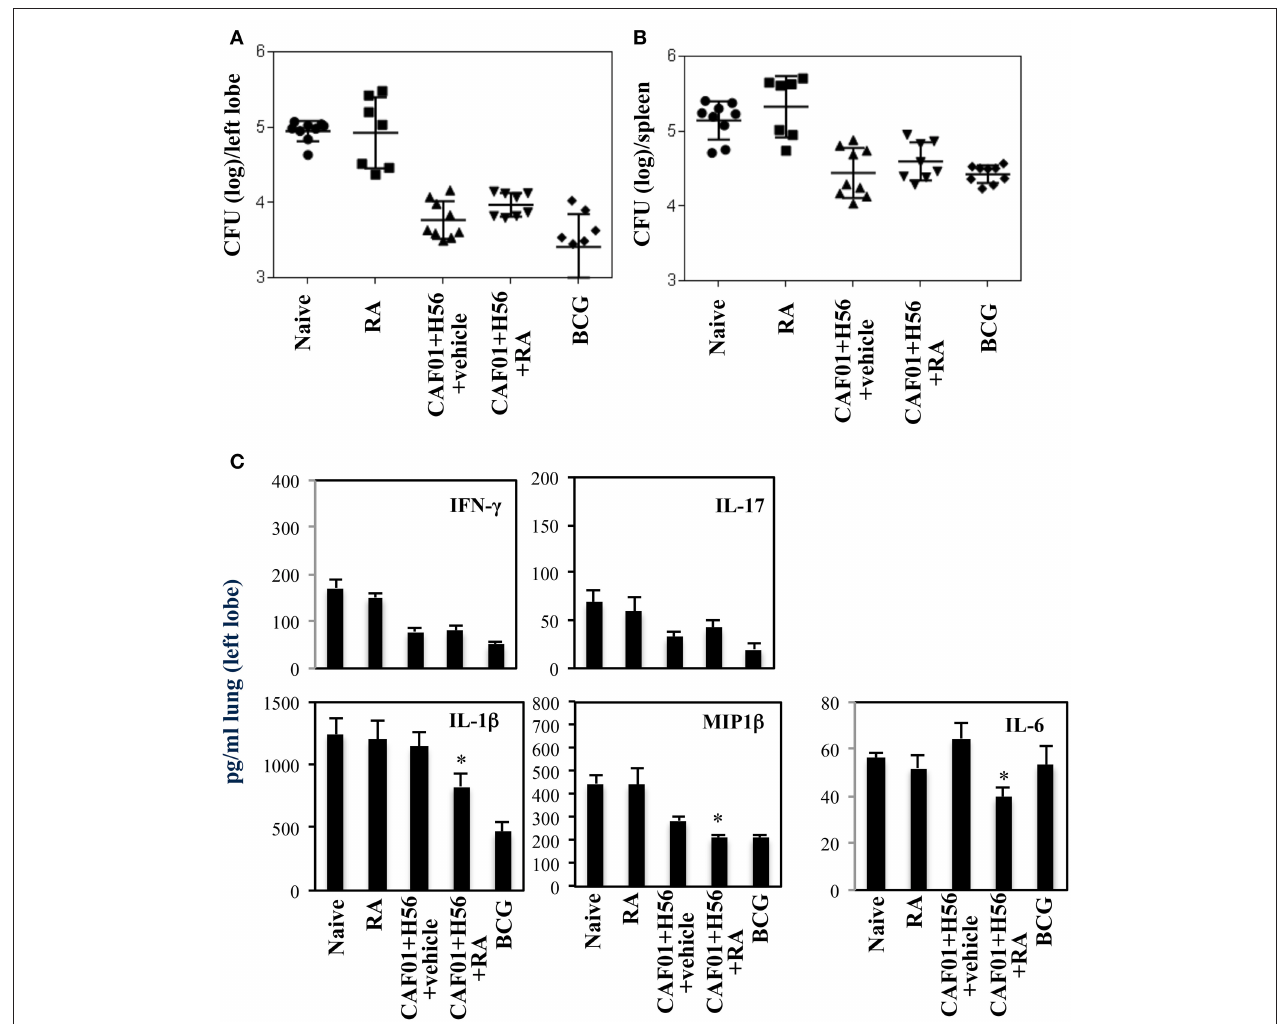
FIGURE 5 | Colony forming unit (CFU) in the lung (A) and in the spleen (B) of CB6F1 mice 6 weeks after Mtb infection. Mice (7–9/group) were treated or untreated with RA (300 µ g/dose, 200 µ g/dose and 100 µ g/dose) or its vehicle, parenterally immunized with H56 (0.5 µ g/dose) and CAF01 (125 µ g/dose) and infected with Mtb (10 5 CFU) 1 month after last immunization. Colony forming units were enumerated 6 weeks after challenge. Results are expressed in log 10 of the number of CFU/ml. Bars indicate SEM. Pro-inflammatory cytokine production (C) in the lung homogenates of CB6F1 mice 6 weeks after Mtb infection. IFN γ , IL-17, IL-1 β , MIP1 β and IL-6 levels were analyzed by ELISA assay in the lung homogenates and stars (*) indicate that the differences between the group treated with RA and the group treated with its vehicle are significant ( p < 0.05). One rapresentative experiment is shown of three